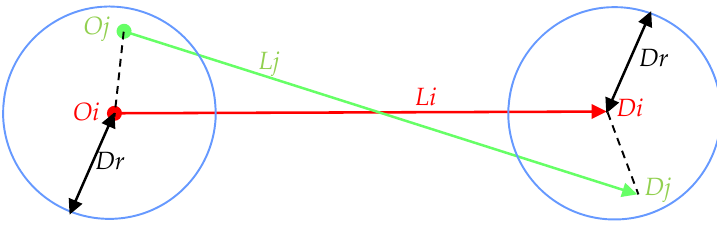
Figure 1. Defining neighboring line of a centerline.